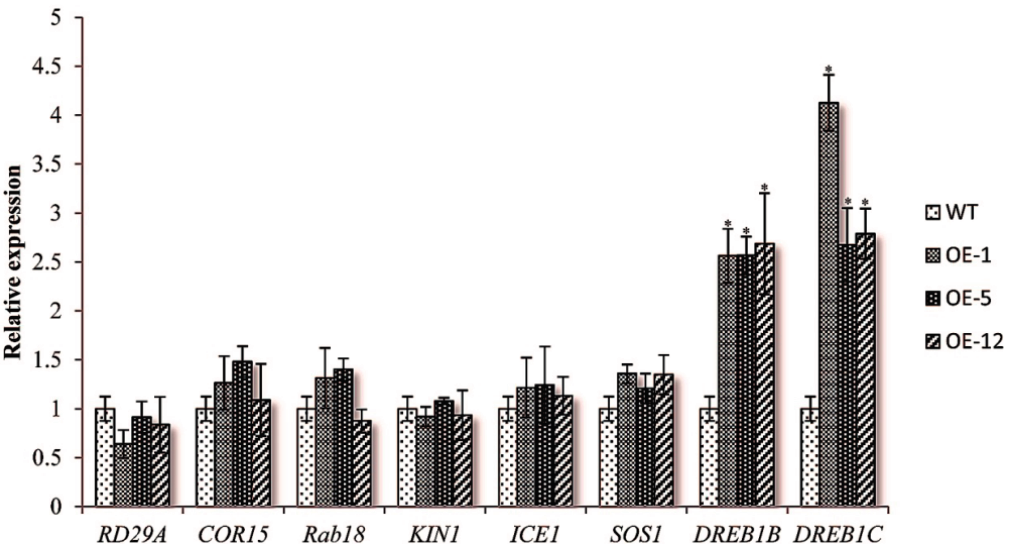
Figure 3. Expression patterns of stress-related marker genes in ZmCIPK21 -OE and wild-type seedlings. Plants were grown for 16 days under normal conditions, and RNA was isolated from each sample. Gene expression was assayed by quantitative reverse transcriptase-polymerase chain reaction (qRT-PCR) with gene-specific primer pairs. The Arabidopsis actin gene was used as a reference. The 2 −∆∆ C t method was used to measure the relative expression level of the target gene. Expression values in transgenic plants were compared with those in wild-type plants. The experiments were performed in triplicate, and values are the means ± SE of three samples. Asterisks indicate significant differences from the wild type at * p <